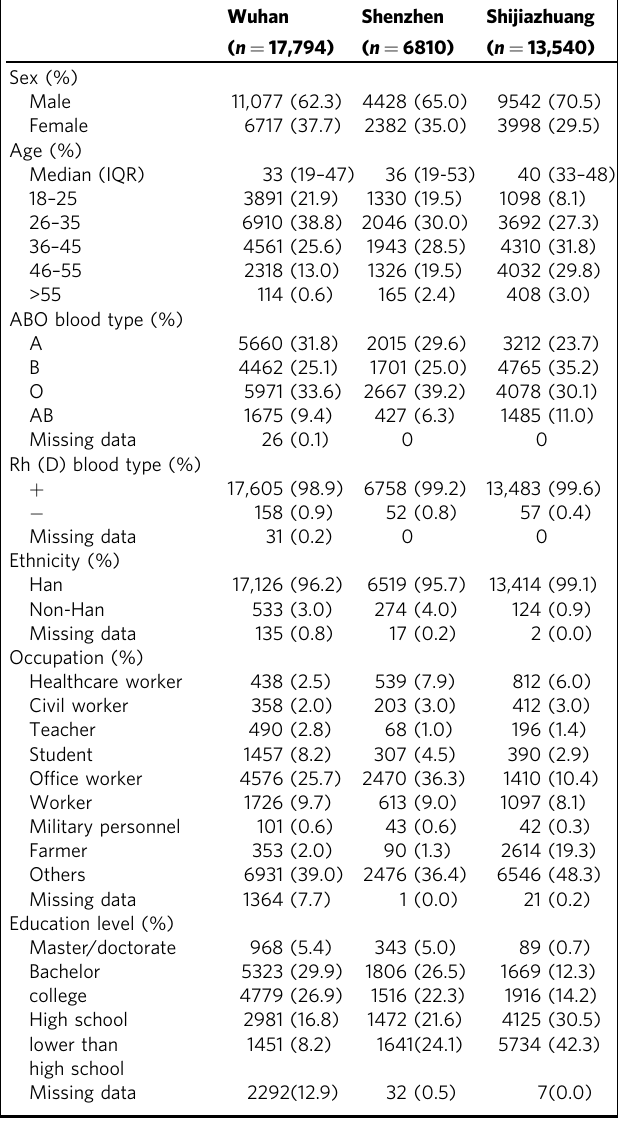
Table 1 Characteristics of enrolled blood